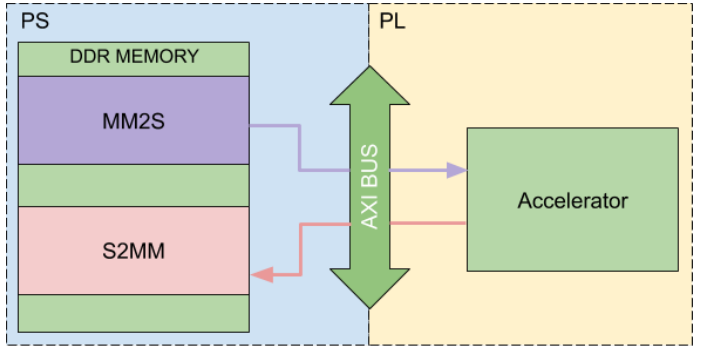
Figure 2. Memory organization for Petalinux AXI-DMA (Advanced eXtensible Interface-Direct Memory Access) native